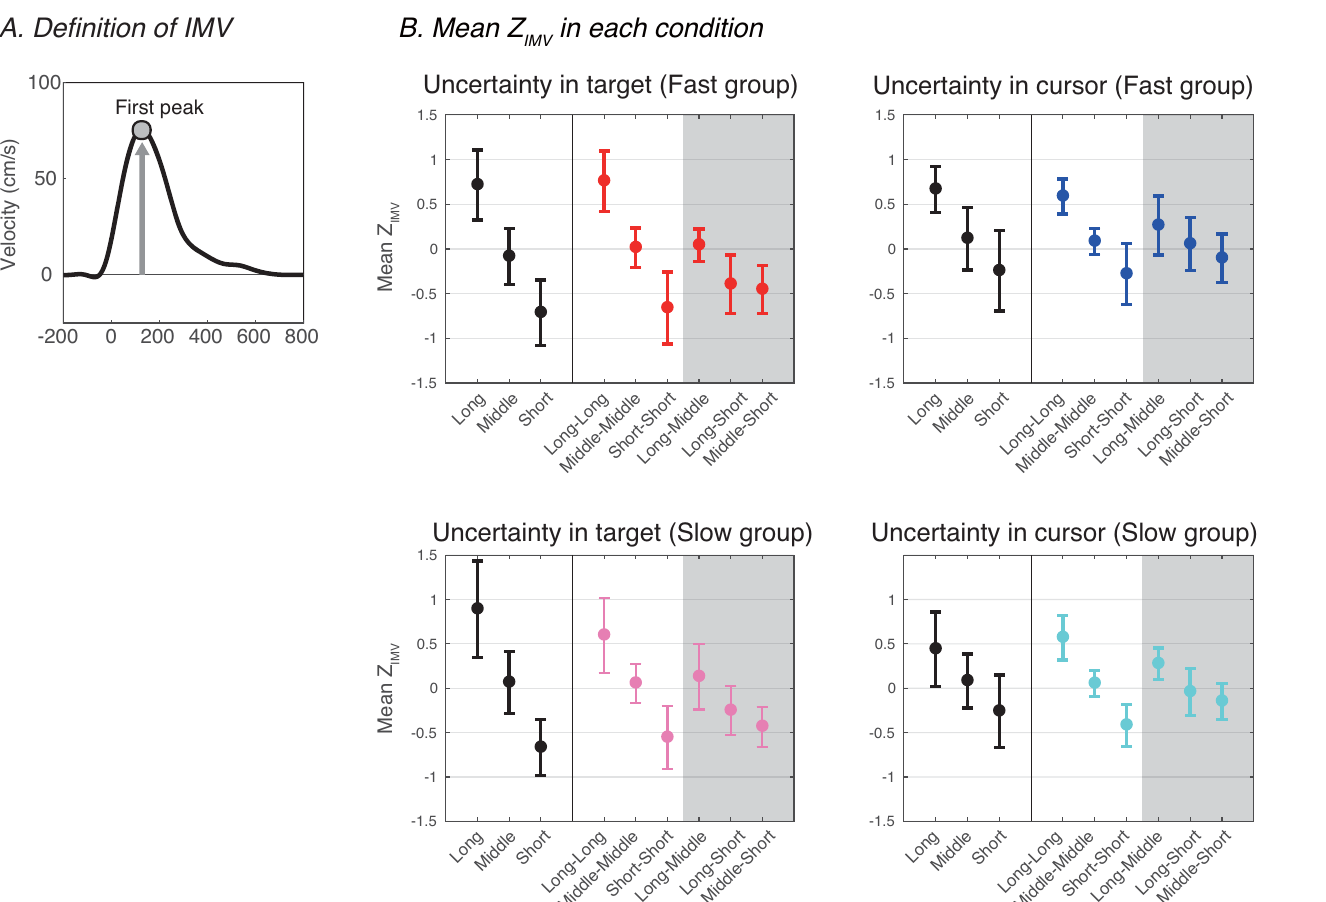
Fig 3. Comparison of mean Z IMV and mean Z IMV among conditions. (A) Definition of initial movement velocity (IMV). To offset the differences in velocity ranges between participants, IMV was z-valued within each set (72 trials) for later analysis. (B) Inter-participant means of Z show the inter-participant means and standard deviations of the IMV z-values ( Z IMV ). Black circles show the data in one-potential conditions (i.e., the one- cursor and one-target conditions) and other colored circles show the data in two-potential conditions (i.e., the two-cursor and two-target conditions). The upper row corresponds to the Fast group and the lower row to the Slow group.